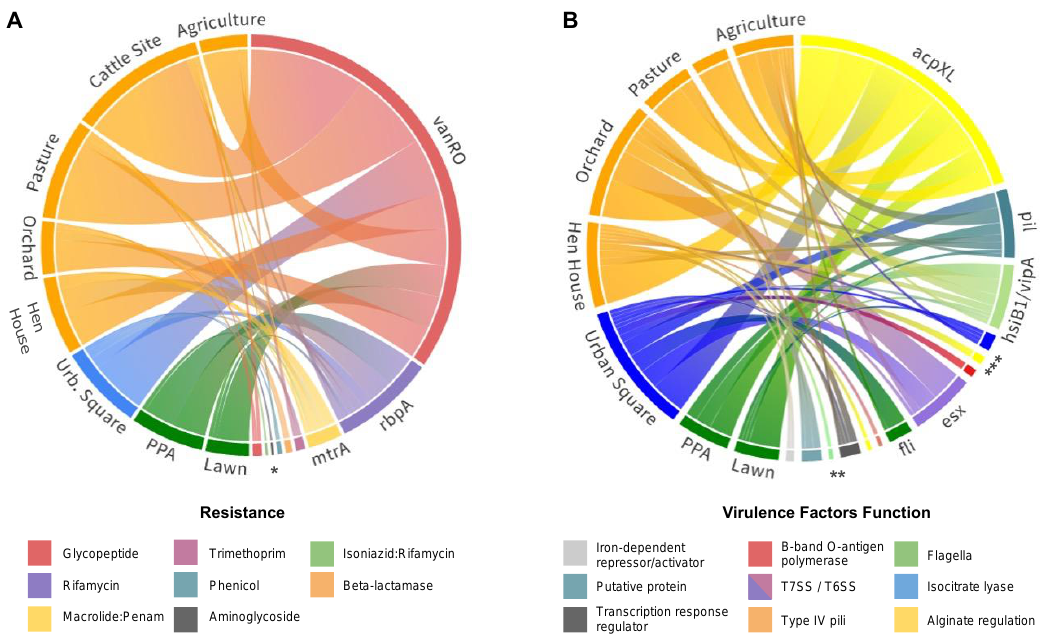
Figure 4. Identified gene distributions across sequenced soil samples. ( A ) Chord diagram showing the distribution of different ARGs per soil metagenome. Resistance genes are colored by resistance category and soil sites are colored by land-use system as follows: orange—farming; blue—urban; green—forest. ( B ) Chord diagram showing the distribution of different VFs per soil metagenome. Virulence-related genes are colored by function, as indicated in the legend. ( acpXL , alg , mucD ) Acyl carrier proteins; ( icl ) isocitrate lyase; ( hsiB1/vipA ) type VI secretion system, T6SS; ( flg, fli, cheW ) Flagella; ( pil ) type IV pili; ( esx ) type VII secretion system, T7SS; ( waaG ) B-band O-antigen polymerase; ( phoP ) possible two-component system response transcriptional positive regulator; ( mbtH ) putative protein; ( ideR ) iron-dependent repressor and activator. * ( vanSO, efpA, aac2-lb, cpt, bla, dfrB ); ** ( ideR, mbtH, phoP, mucD, waaG ); *** ( flgC, alg, icl ). Resource: